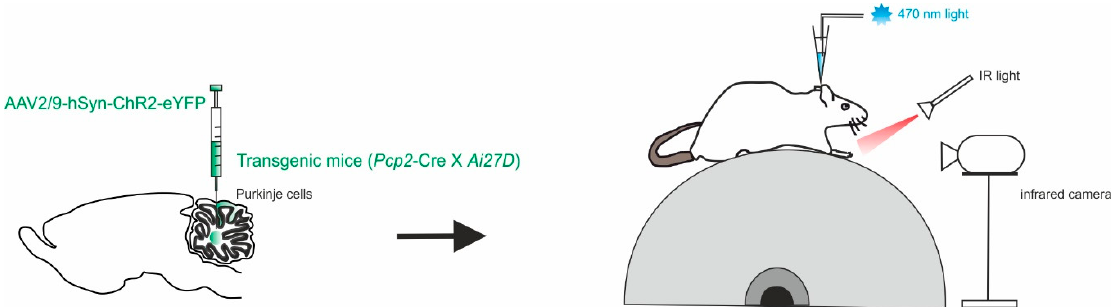
Figure 2. Modulation of PCs and DCN during voluntary locomotion. Left , in Pcp2 -cre mice, a mixture of viruses (AAV2/9) was injected to express ChR2 with a fluorescent marker conjugated with eYFP in the interpositus nucleus. Right , schematics of the setup with a head-fixed mouse running on the cylindrical treadmill. Paw movements are recorded with an infrared camera. The patch pipette contained an electrode wire and an optical fiber.